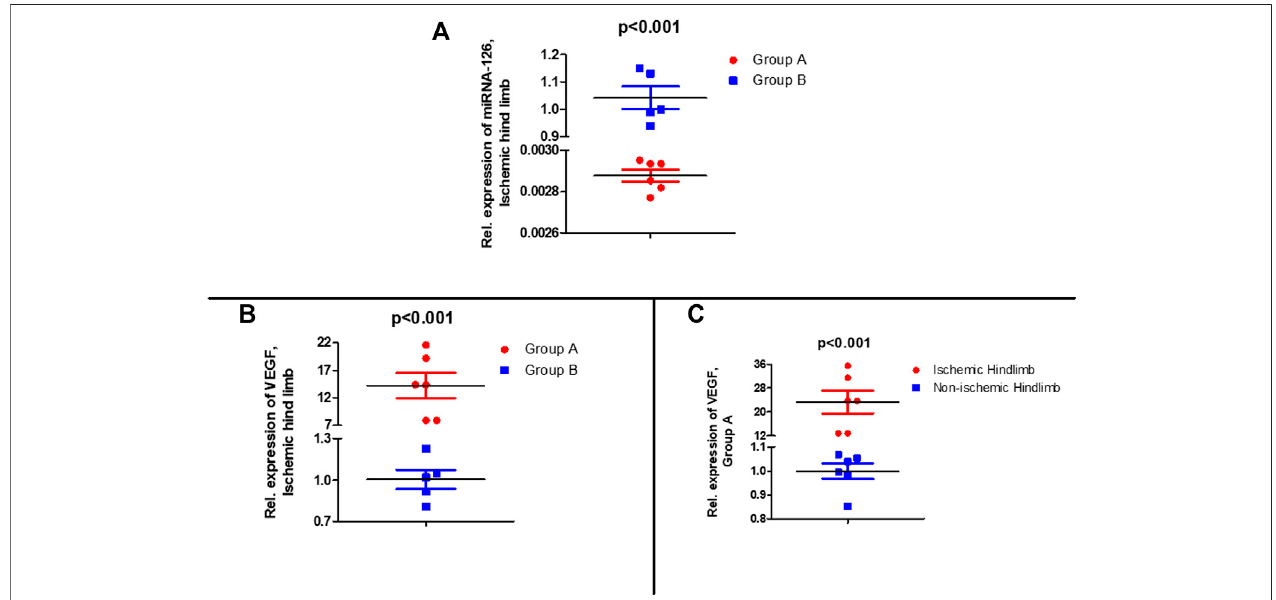
FIGURE 2 | (A) Relative expression of microRNA-126 in muscle tissue of the ischemic hind limb of microRNA-126 treated group compared control group after euthanasia (28th day), (B) Relative expression of microRNA-126 vascular endothelial growth factor (VEGF) in muscle tissue of the ischemic hind limb of microRNA-126 treatedgroupcomparedcontrolgroupaftereuthanasia(28thday), (C) RelativeexpressionofVEGFinmuscletissueoftheischemichindlimbcomparedtonon-ischemic hind limb of microRNA-126 treated group after euthanasia (28th day).